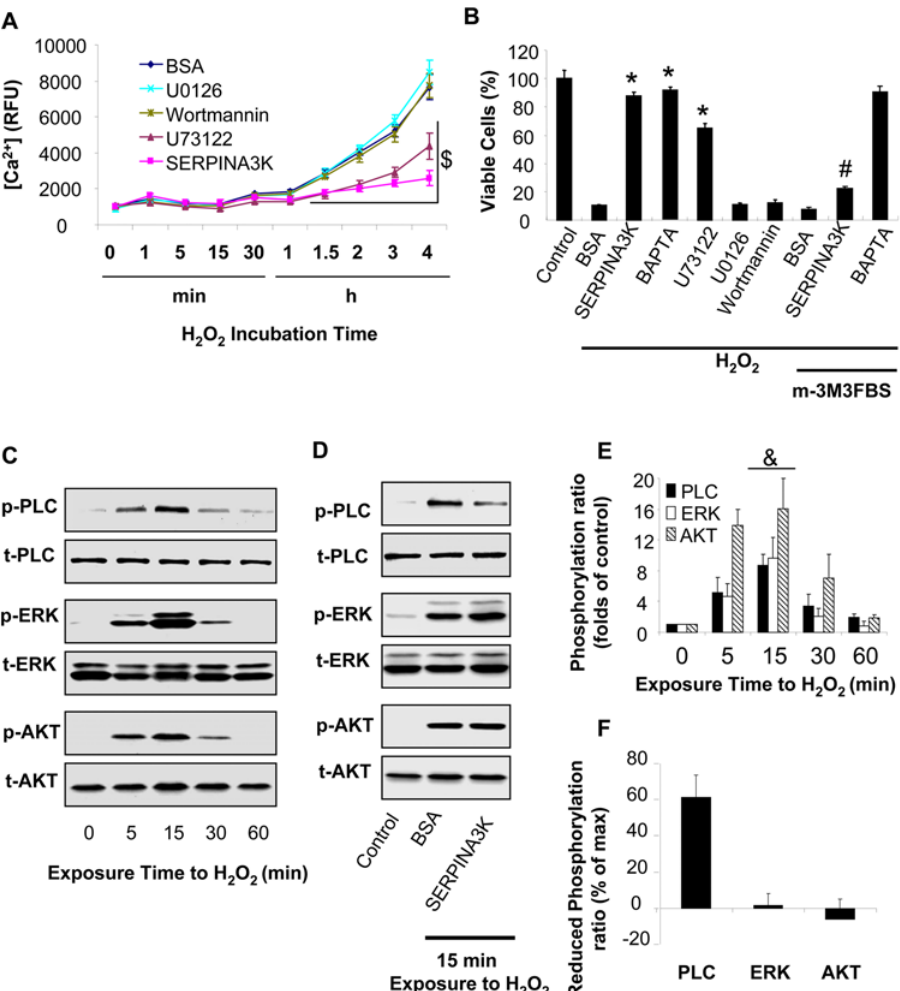
Figure 6. SERPINA3K inhibits the H 2 O 2 -induced calcium overload and necrosis via PLC but not the ERK or PI3K/Akt pathways. ( A ) The rMC-1 cells were treated with 400 m M H 2 O 2 in the presence of 1 m M SERPINA3K, 250 nM U73122 (PLC inhibitor), 10 m M U0126 (ERK inhibitor), 100 nM Wortmannin (PI3K inhibitor) or 10 m M BAPTA. BSA (1 m M) was used as negative control. Intracellular [Ca 2 + ] was measured using the fluorescence of the probe Fluo-4/AM at different intervals of the treatment (mean 6 SEM, n=6). ( B ) The protective effects of the inhibitors and 1 m M SERPINA3K against the H 2 O 2 -induced cell death with or without 10 m M m-3M3FBS (PLC activator) were quantified by the MTT assay after exposure to H 2 O 2 for 8 h (mean 6 SEM, n=3). ( C ) The rMC-1 cells were treated with 400 m M H 2 O 2 . The cells were harvested at different time points for Western blotting. ( D ) The cells were exposed to H 2 O 2 for 15 min in the presence of 1 m M SERPINA3K or BSA. The phosphorylated PLC- c 1 (p-PLC), ERK1/2 (p-ERK) and Akt (p-AKT) were blotted with phosphorylation-specific antibodies. The total PLC- c 1 (t-PLC), ERK1/2 (t-ERK) and Akt (t-AKT) were blotted with antibodies for total proteins. ( E ) Protein levels was quantified using densitometry of the Western blotting results (mean 6 SEM, n=3). ( F ) The reduced phosphorylation level of each kinase was shown as percentages of the maximum phosphorylation levels at 15 min exposure (mean 6 SEM, n=3). $ P , 0.01, under H 2 O 2 exposure from 1.5 h to 4 h; the U73122 and SERPINA3K-treated cells versus the BSA-treated cells. * P , 0.01, versus control cells. # P , 0.01, the cells treated with H 2 O 2 , m-3M3FBS and SERPINA3K versus the cells treated with H 2 O 2 and SERPINA3K. & P , 0.01, versus control cells exposed to H 2 O 2 for 0 min.